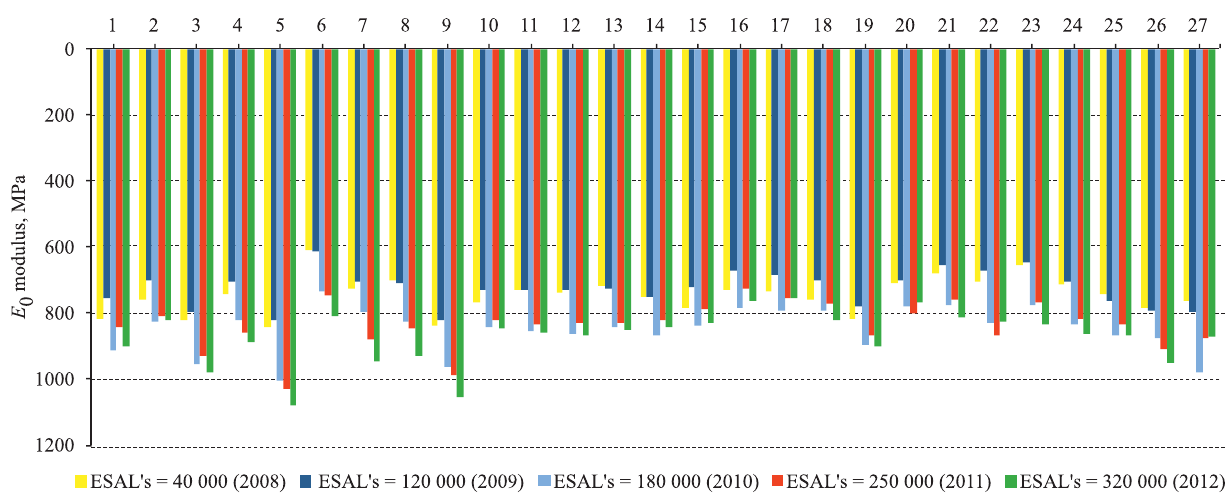
Fig. 6. Equivalent stiffness modulus E 0 of pavement structures measured in spring with FWD in the rut of loaded traffic